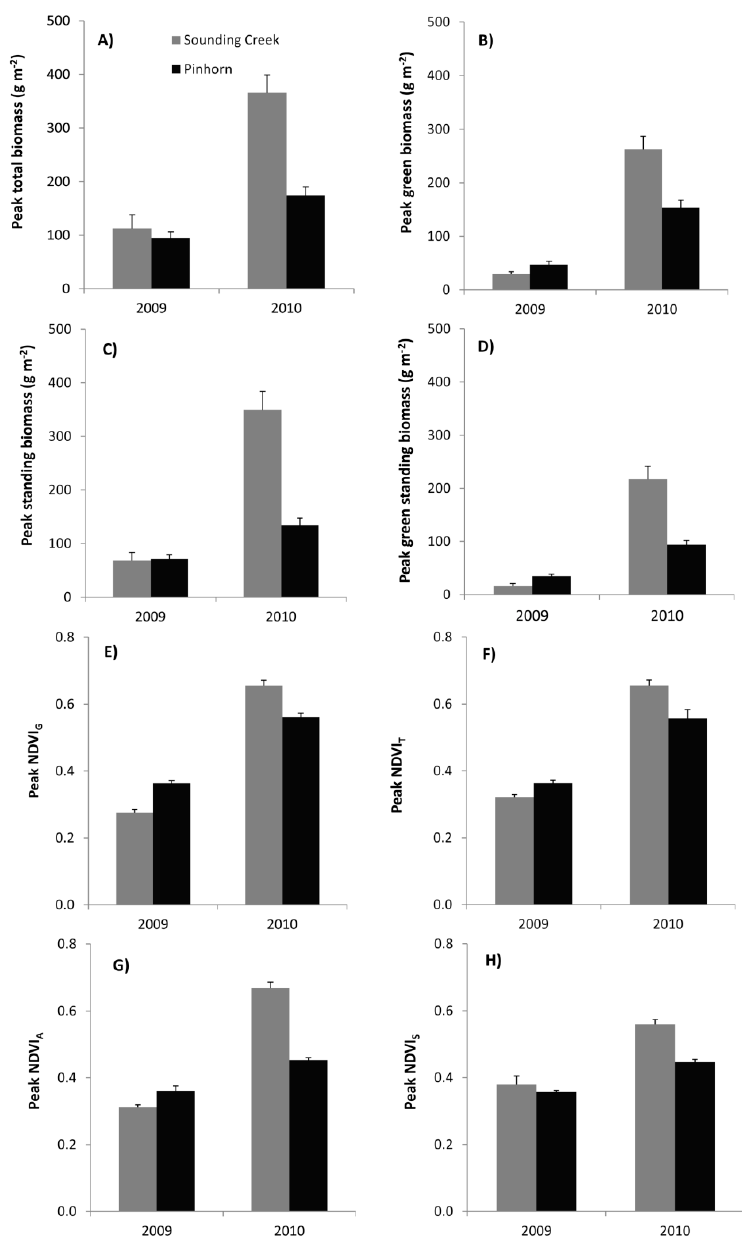
Figure 8. July (peak) values for total biomass ( A ); green biomass ( B ); standing biomass ( C ); green standing biomass ( D ); NDVI from ground spectrometry ( E ); and NDVI derived from the Terra ( F ); Aqua ( G ) and SPOT ( H ) satellites from the Sounding Creek and Pinhorn grazing reserves in the 2009 and 2010 growing seasons. Error bars denote the standard error of the mean.